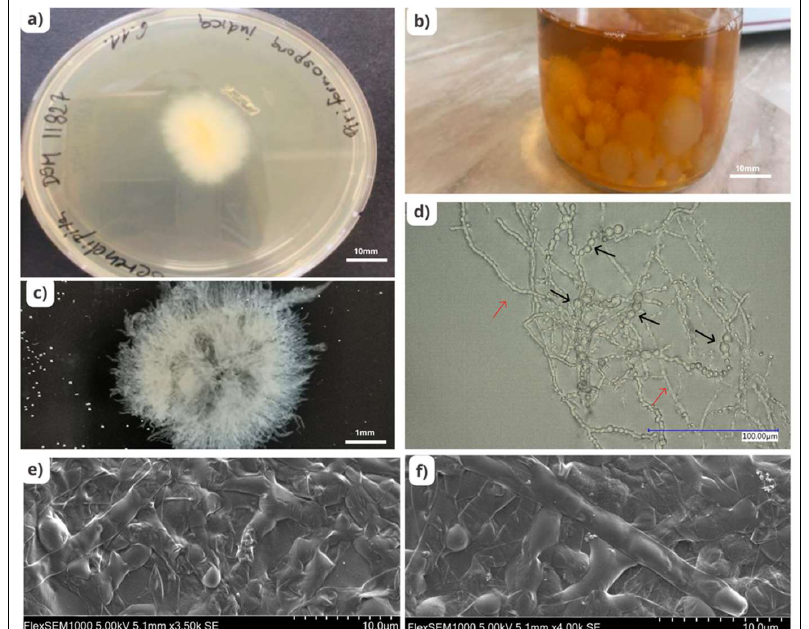
Figure 1. Morphology of Serendipita indica . ( a ) Growth of S. indica colony on PDA media; scale bars of 10 mm. ( b ) Growth of S. indica colony in PDB media; scale bars of 10 mm. ( c ) Growth of S. indica from PDB medium; scale bars of 1 mm. ( d ) Chlamydospores (black arrows) and mycelium (red arrows) of S. indica observed under a bright field microscope; scale bars of 100 µm. ( e , f ) Mycelial structure of S. indica observed under an electron microscope.